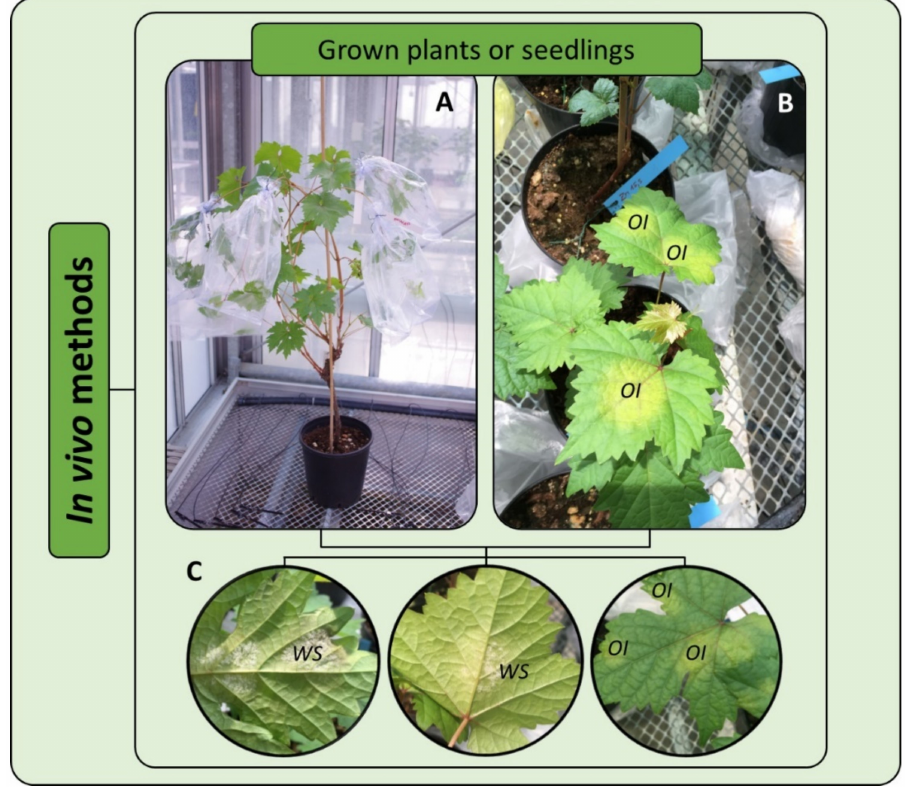
Figure 4. In vivo tests carried out on grapevine plants ( A , B ) aiming at assessing fungicide resistance through the evaluable 50 value of the P. viticola population. OI = oil spot symptom on the upper side of the leaf; WS = white sporulation, consisting of sporangiophores and sporangia, on the underside of the